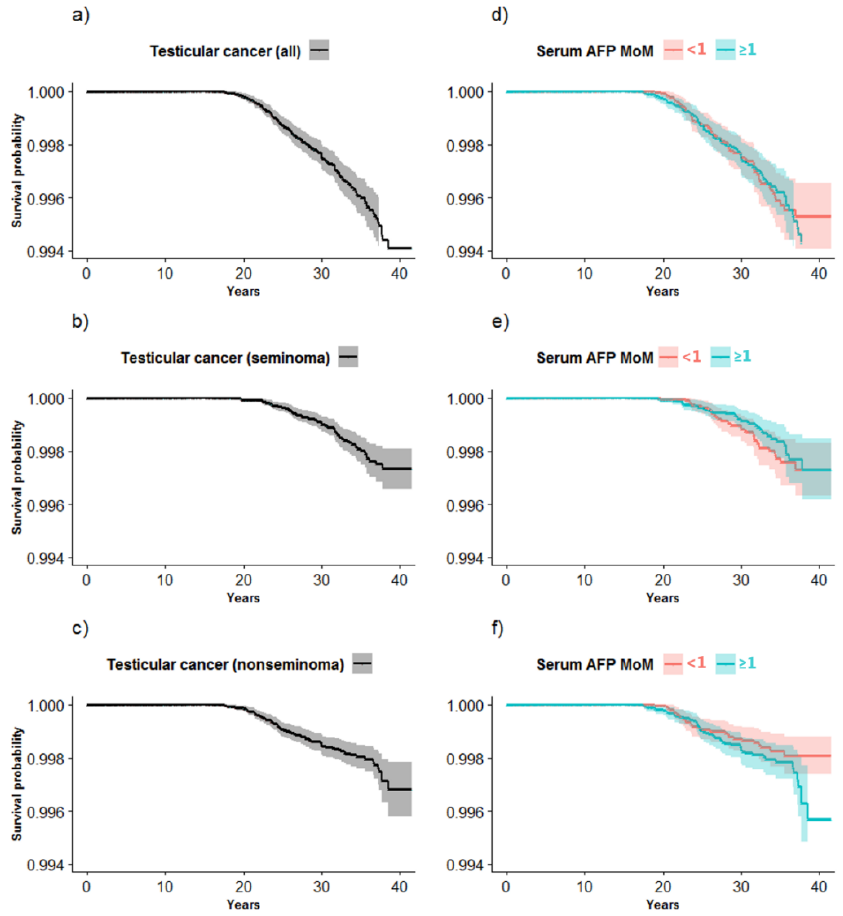
Figure 2. ( a – f ). Kaplan–Meier plots for time course free of all, seminoma and nonseminoma (incl. mixed germ cell tumors) testicular cancer ( a – c ) and plots stratified according to serum α -fetoprotein (AFP) multiples of the median (MoM: <1.00/≥1.00) for ( d ) all, ( e ) seminoma and ( f ) nonseminoma testicular cancer.